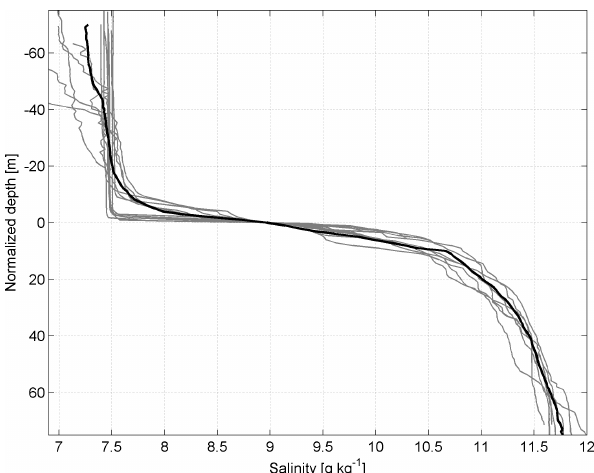
Figure 2. Vertically normalized salinity profiles from 30 January to 4 August 2020 in the northern Baltic Proper (see Fig. 1b). The bold black line represents the mean salinity